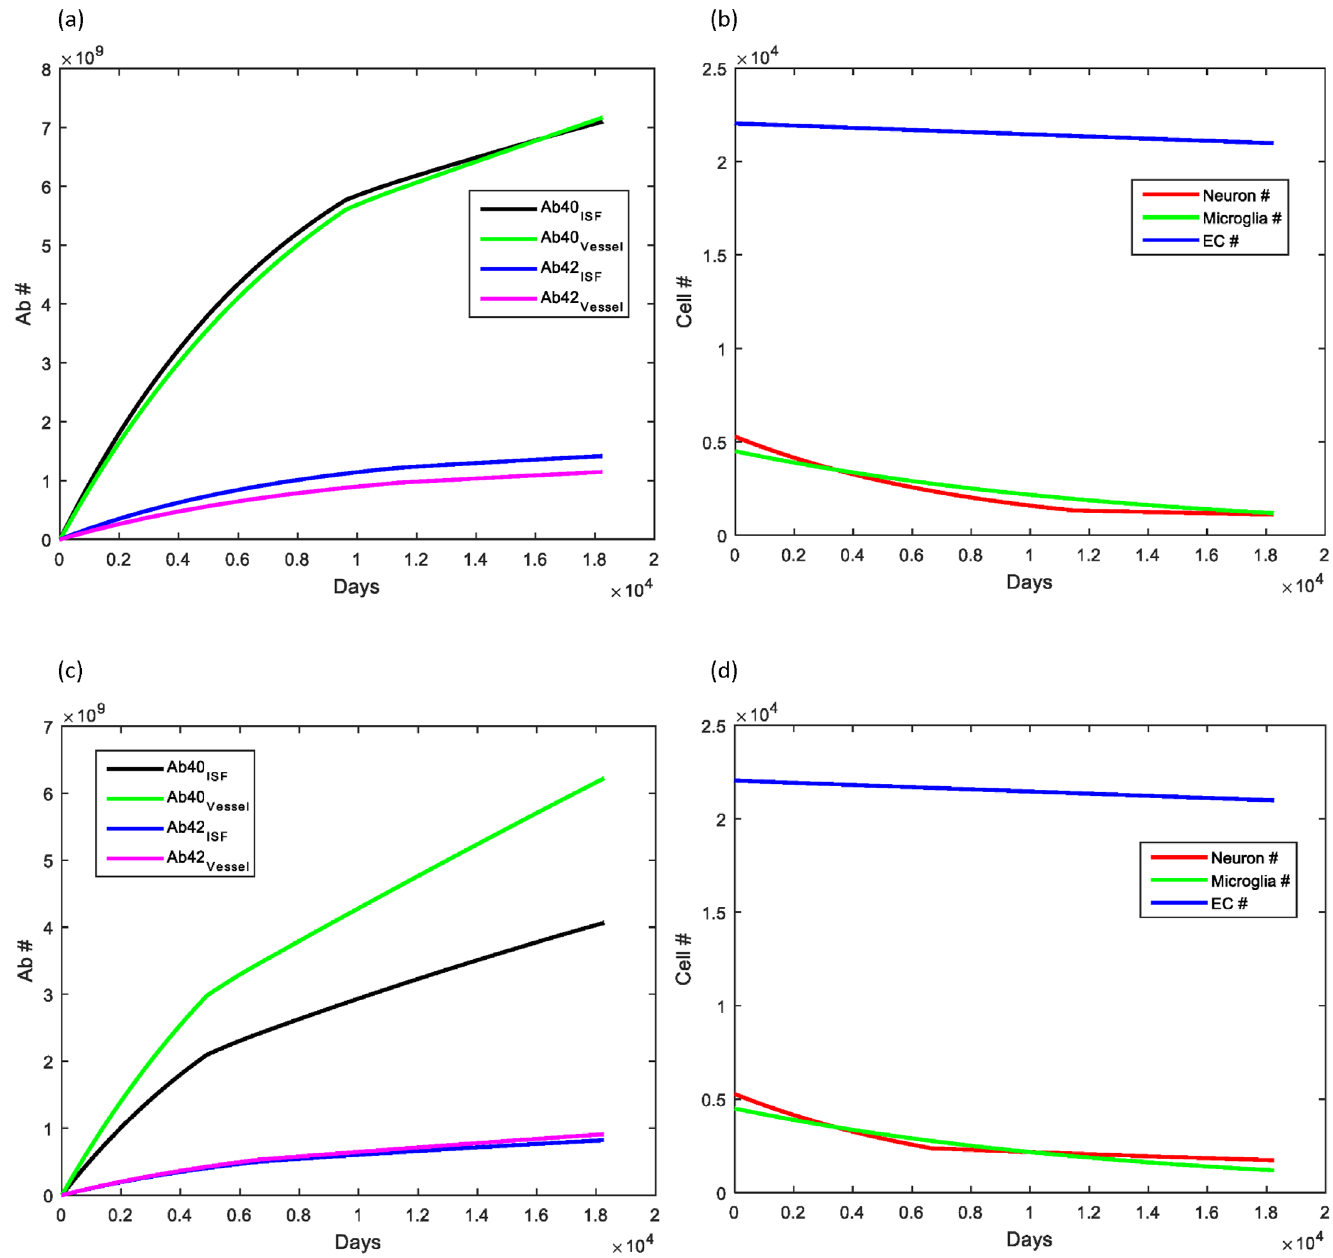
Fig 4. Effect of heart rate on A β clearance and deposition. (A, B) Decreasing the heart rate by only 10 beats per minute (60 to 50) led to nearly a 20% increase in the A β deposition in the brain parenchyma and a 5% increase in the cerebral vasculature. (C, D) Increasing heart rate by 30 beats per minute (60 to 90) led to the converse, with A β deposition levels in brain parenchyma decreasing about 30% and in the cerebral vessels decreasing about